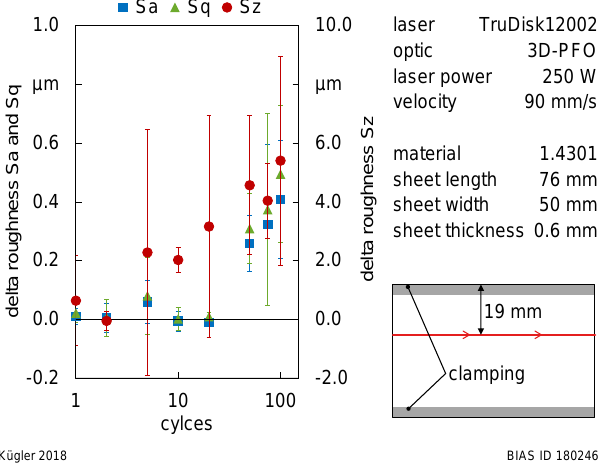
Figure 8. Roughness measurements for varying laser processing cycles.